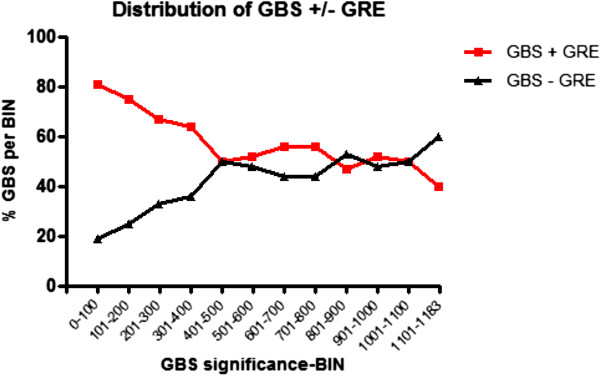
Significance of GR-binding sites with and without a GRE. GR binding sites containing a GRE-like sequence have smaller p-values in the ChIP-Seq data compared to those regions without a GRE. On the x-axis the 1183 GBS are ranked into BINs consisting of 100 binding regions ranked according to significance. For example, the 100 most significant GBS are represented in BIN 1 (1–100), while the 83 least significant GBS are represented in the last BIN (1101–1183). On the y-axis the percentage of GRE and non-GRE containing GBS per BIN is indicated.